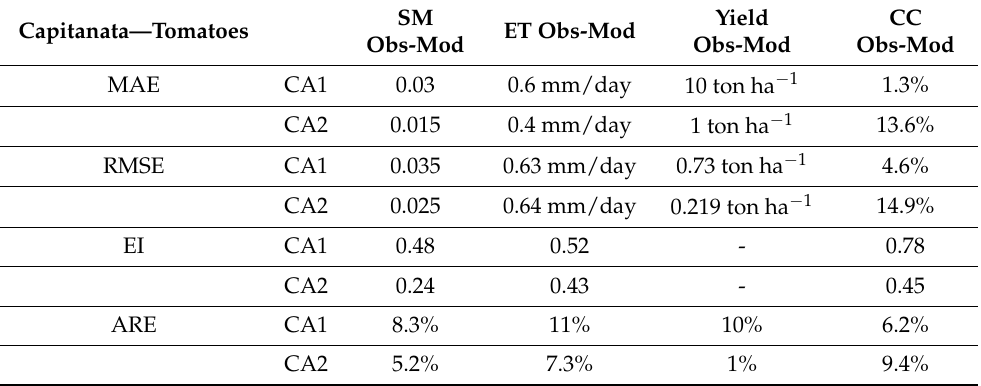
Table 4. Statistical indices results for model calibration in the Capitanata Irrigation Consortium.